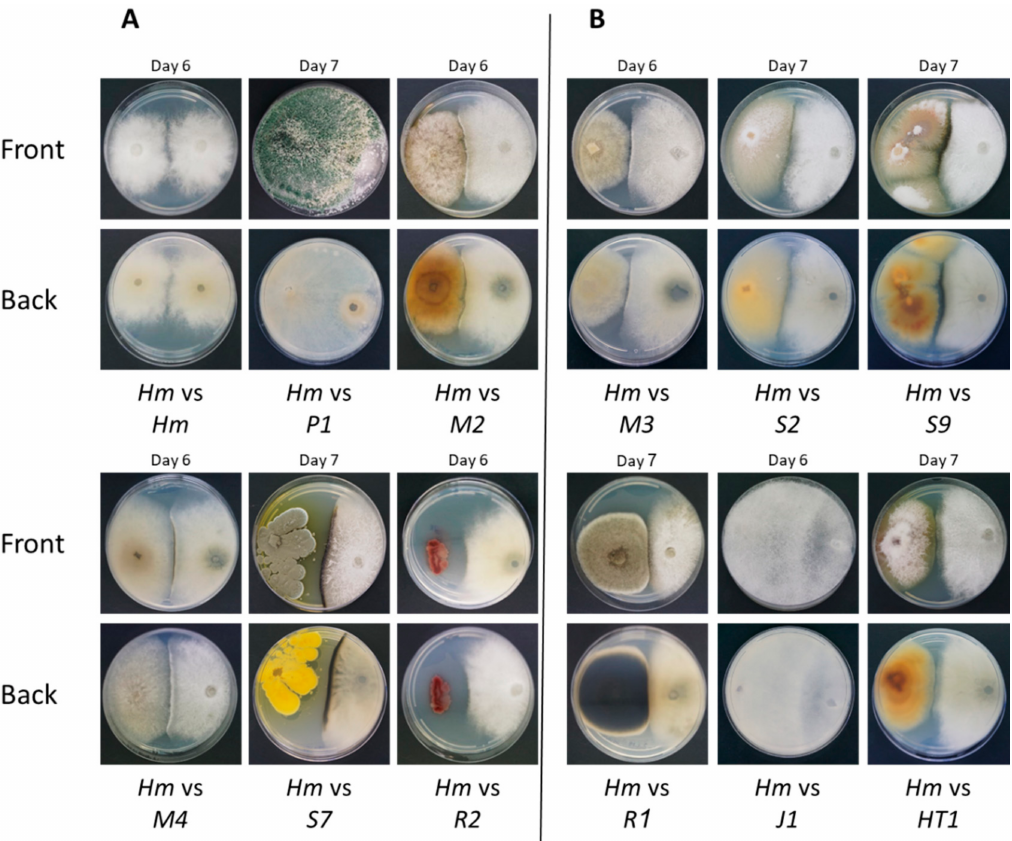
Figure 2. Plate confrontation assays. The PDA plate assay to identify interactions between Magnaporthiopsis maydis and different endophytes. The endophytes species tested are listed in Table 3. Upper left-most panel— M. maydis ( Mm ) was seeded on both sides of the petri dish. Other panels—the two fungi were planted opposite each other, endophytes species on the left, M. maydis on the right. ( A ). The endophytes selected for the subsequent sprout pathogenicity assay. ( B ). Endophytes species not selected for the sprouts assay. Each plate was photographed from both sides, front (upper panel) and rear (lower panel). Images were taken at 6–7 days of growth at 28 ± 1 ◦ C in the dark as detailed above each